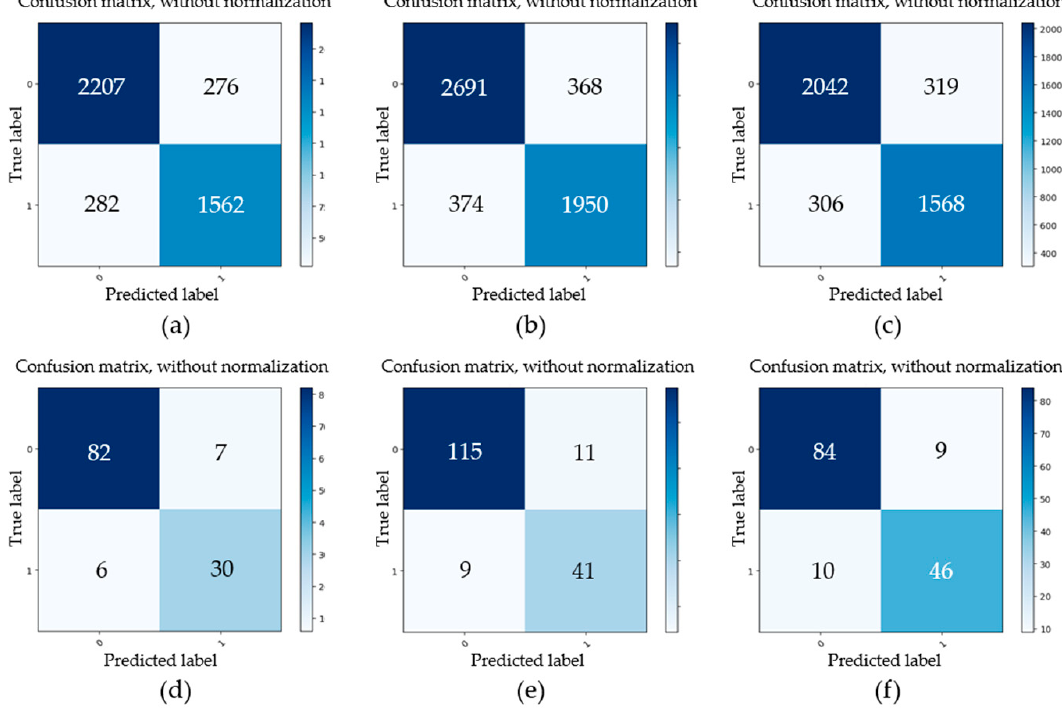
Figure 13. Evaluation parameters of gear pitting and TS under different shooting angles. (a) 15° (pitting); (b) 45° (pitting); (c) 75° (pitting); (d) 15° (TS); (e) 45° (TS); (f) 75° (TS).